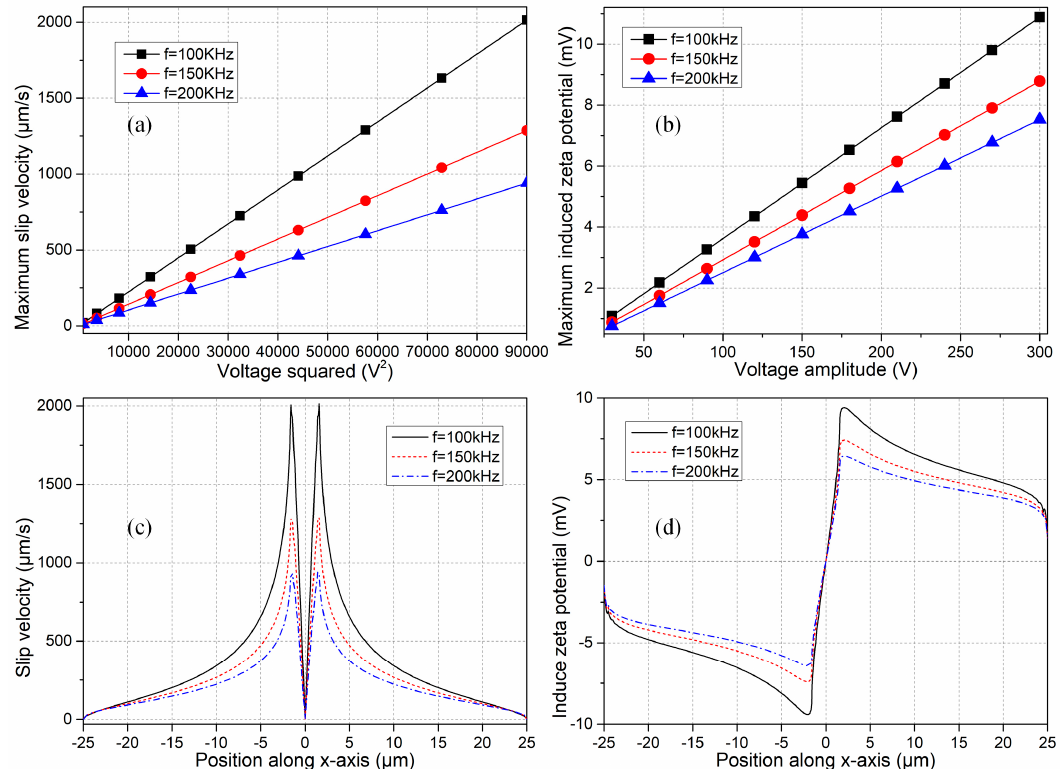
Figure 6. Effect of electrical field parameters on induced polarization and ICEO flow field next to a leaky dielectric block of σ b = 10 − 7 S/m and ε b = 20 ε 0 . ( a , b ) Influence of voltage amplitude of the imposed AC signal on, ( a ) electroosmotic fluid motion; and ( b ) counterionic charge within the Debye layer, for different field frequencies in the context of high-frequency range ( f ≥ 100 kHz). It is worthy to note that the induced zeta potential is even less than one thermal voltage of 25 mV on the surface of the nearly insulating semiconductor block. ( c , d ) Position-dependent distribution of, ( c ) ICEO slip velocity; and ( d ) double-layer voltage drop, on the block surface at a fixed voltage amplitude of A = 300 V for varying field frequencies ( f ≥ 100 kHz).